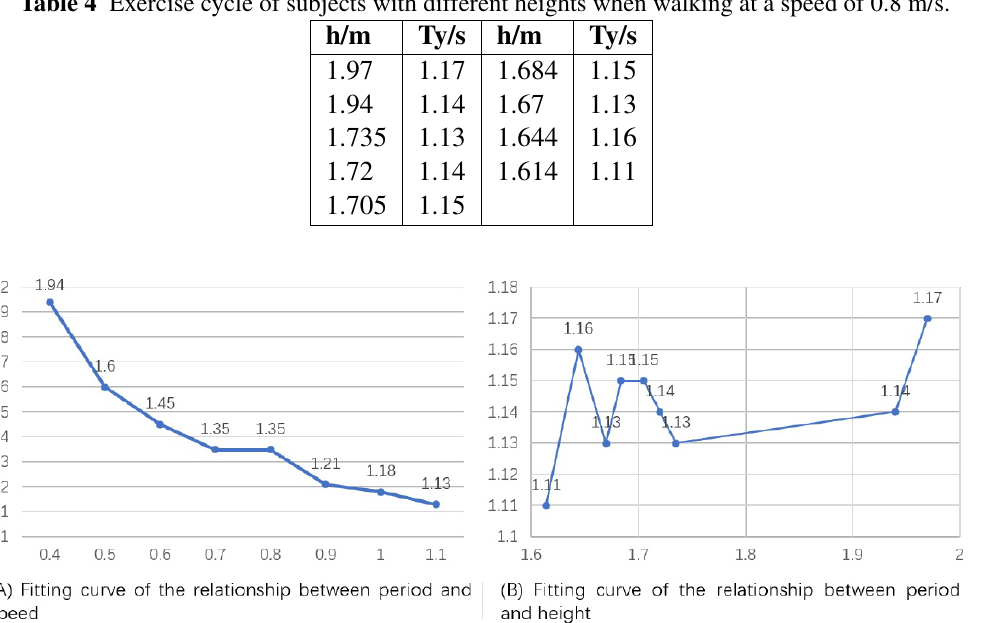
Table 4 Exercise cycle of subjects with different heights when walking at a speed of 0.8 m/s.